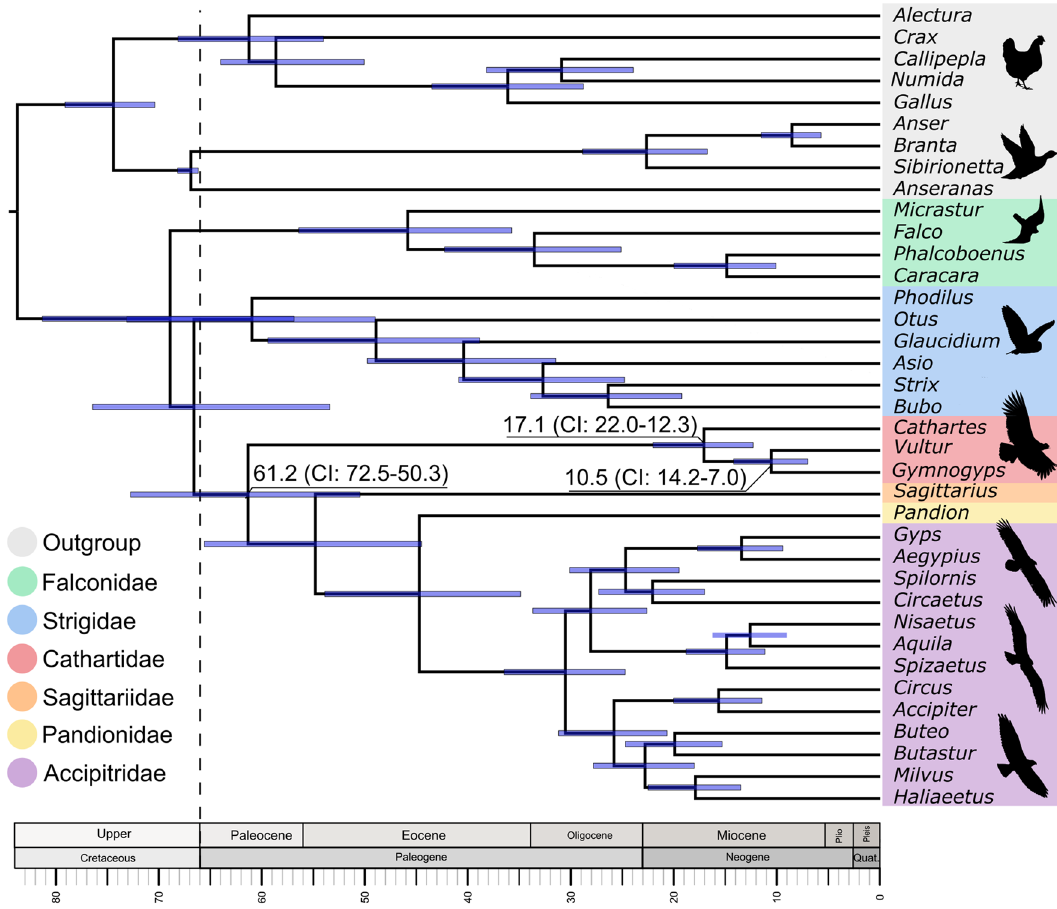
Figure 3. Maximum clade credibility dated tree based on 13 PCGs + 12S and 16S rRNAs (error bars represent 95% CI). Consistent topologies were recovered from ML and BI trees (Figure S5). The inferred ages for Cathartidae are shown. The tree was obtained with FigTree 1.4.4 (https:// anaco nda. org/ bioco nda/ figtr ee) and the figure was edited with Inkscape 1.1 (http:// www. inksc ape.